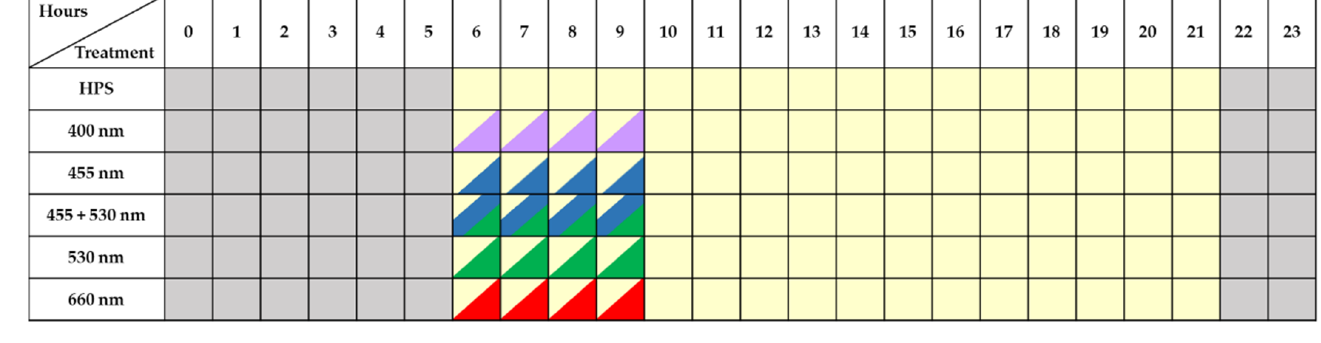
Figure 1. The lighting scheme of 1st experiment (EXP1).